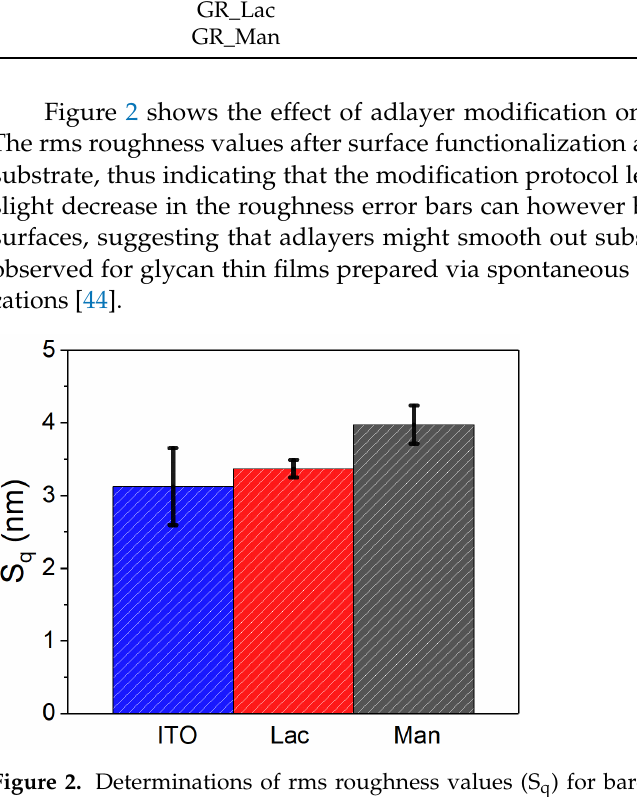
Figure 2. Determinations of rms roughness values (S q ) for bare ITO (blue), ITO_Lac (red), and ITO_Man (grey) samples.